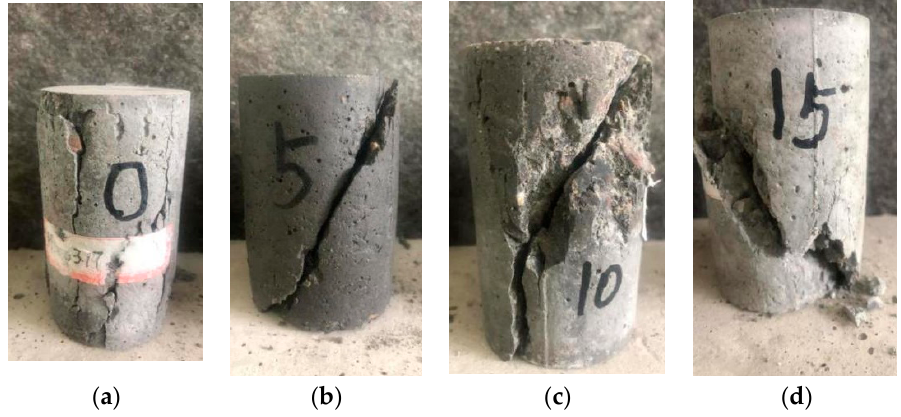
Figure 12. ( a ) σ 2 = σ 3 = 0 MPa; ( b ) σ 2 = σ 3 = 5 MPa; ( c ) σ 2 = σ 3 = 10 MPa; and ( d ) σ 2 = σ 3 = 15 MPa.